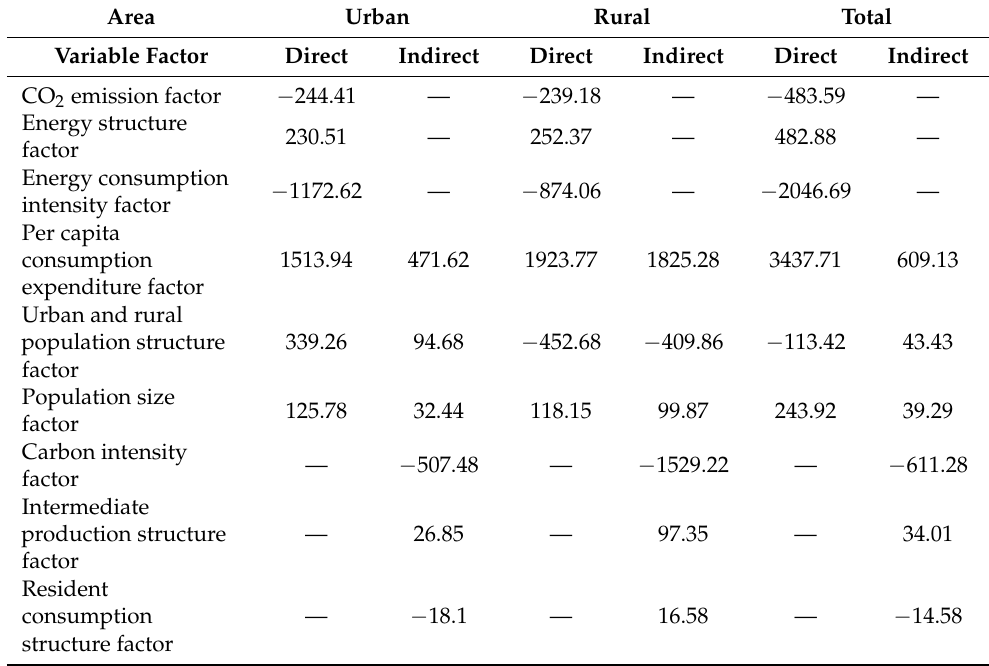
Table 2. Summary of the impacts of the urban and rural DHCEs and